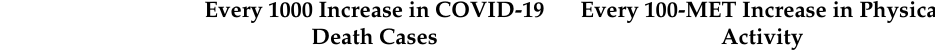
Table 2. Relationship between COVID-19 death count and physical activity, sleep quality, and negative emotions. Every 1000 Increase in COVID-19 Every 100-MET Increase in Physical Death Cases Activity Point Estimate 95% CI Point Estimate 95% CI Sleep quality score 0.15 ( − 0.11, 0.41) 0.0015 ( − 0.0074, 0.010) Sleep onset latency score − 0.07 ( − 0.24, 0.09) 0.0011 ( − 0.0058, 0.0081) Sleep duration score 0.07 ( − 0.13, 0.26) 0.0026 ( − 0.0046, 0.0098) Sleep e ffi ciency score 0.29 * (0.15, 0.44) 0.0001 ( − 0.0064, 0.0066) Sleep disturbance score 0.16 ( − 0.08, 0.40) 0.0026 ( − 0.0075, 0.013) Sleep medicine use score − 0.0002 ( − 0.02, 0.02) − 0.0001 ( − 0.0010, 0.00080) Daytime dysfunction 0.12 ( − 0.04, 0.29) 0.0054 ( − 0.0015, 0.012) Global PSQI score 1.37 * (0.55, 2.19) 0.0110 ( − 0.022, 0.044) Stress score − 0.66 ( − 2.09, 0.77) − 0.0389 ( − 0.085, 0.0068) Anxiety score 0.18 ( − 0.95, 1.31) − 0.03 ( − 0.067, 0.0026) Depression score − 0.03 ( − 1.33, 1.26) − 0.04 * ( − 0.080, − 0.0022) Global DASS score − 0.01 ( − 3.54, 3.52) − 0.12 * ( − 0.22, − 0.010) Aggressiveness score − 6.57 * ( − 12.78, − 0.36) − 0.03 ( − 0.17,